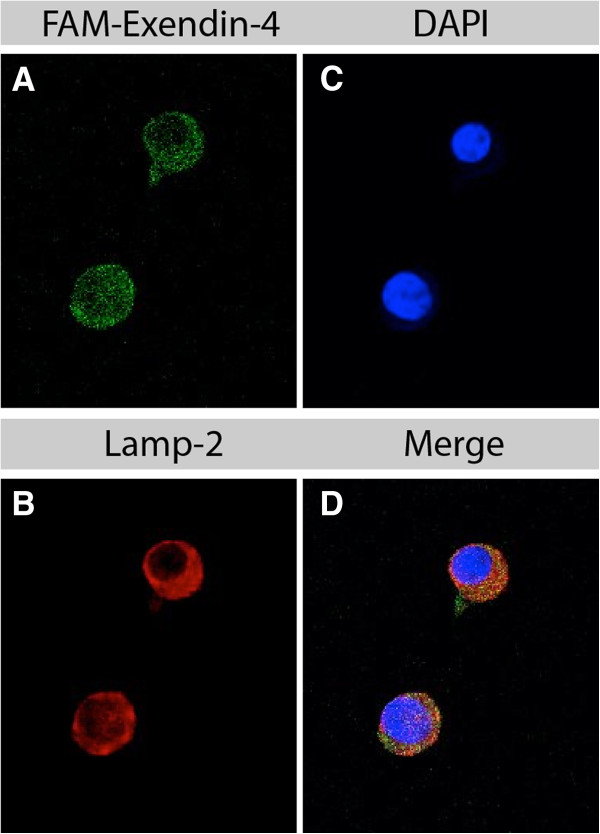
Subcellular localization of exendin-4 in cultivated tumor β-cells of Rip1Tag2 mice 2 h after injection. Tumor beta-cells were incubated with FAM-exendin-4 (A, green), anti-Lamp-2 (B, red, an anti-lysosome antibody), and nuclear DAPI stain (C, blue). Fluorescein-exendin-4 was internalized into the cytoplasm and into the nuclei of tumor beta-cells. However, there was only a minimal co-localization of FAM-exendin and Lamp-2 (D, merged picture).